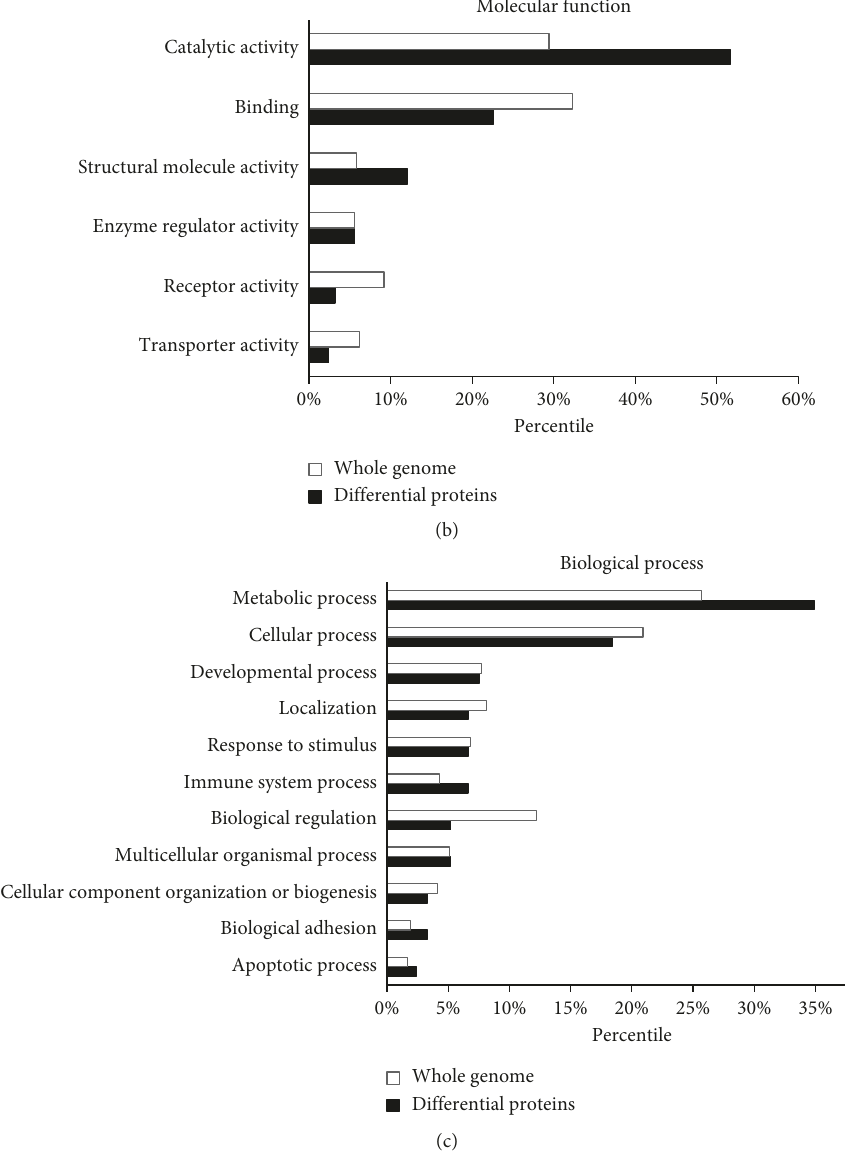
Figure 3: Gene Ontology analysis of the differentially expressed proteins. (a) Cellular component of the whole genome and the differentially expressed proteins in VAT. (b) Molecular function assigned to the whole genome and the differentially expressed proteins in VAT. (c) Biological processes assigned to the whole genome and the differentially expressed proteins in